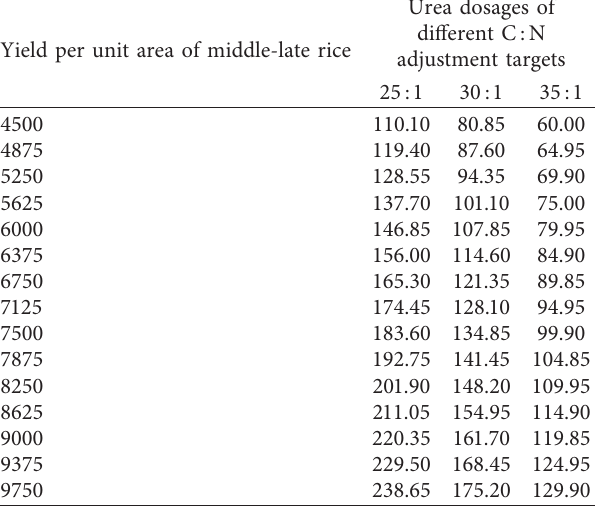
Unit: kg/ha. Table 8: Enquiry table for urea application quantity during middle- late rice straw returning to the field with different yields per unit